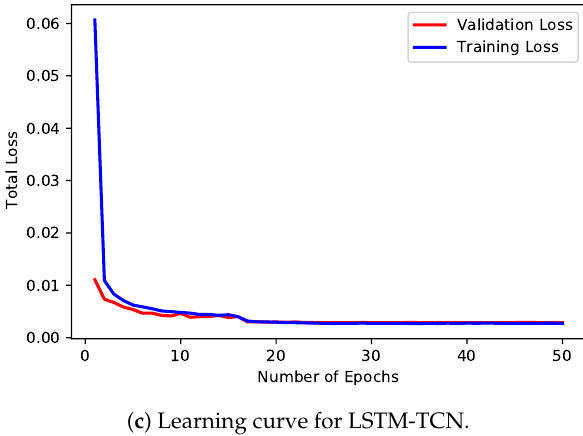
( a ) Learning curve for CNN. ( b ) Learning curve for LSTM.